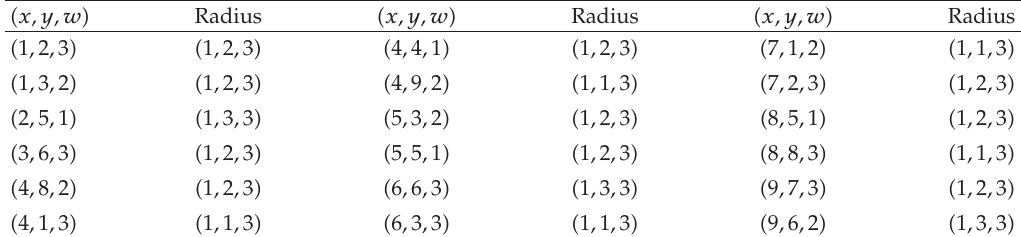
Table 6: Data for 18-point